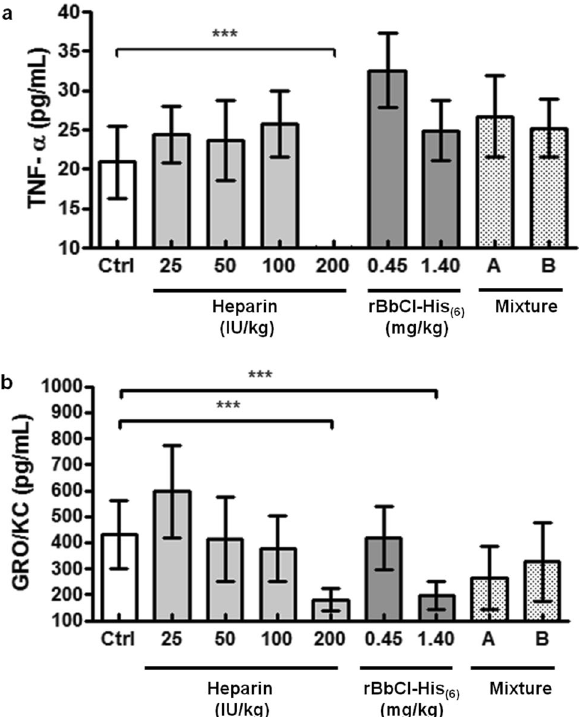
Figure 5. Effect of rBbCI-His (6) associated or not with heparin on serum cytokines levels (TNF-alpha and GRO/KC). Serum samples were collected 4 h after thrombosis induction in rats treated intravenously with saline, inhibitors, or heparin plus rBbCI-His (6) 30 min before ligature (“ex-vivo” group). The concentrations of cytokines were determined in the Milliplex system. Values are expressed as mean ± s.d.. *** p ˂ 0.001 versus the corresponding values in the saline